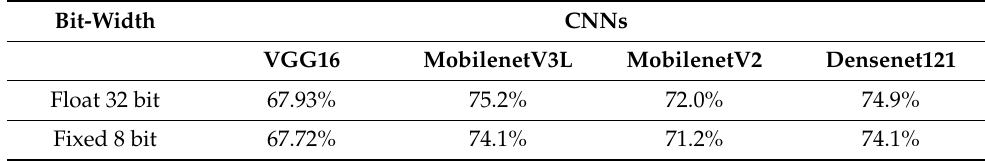
Table 2. The Top-1 accuracy of the CNNs with different